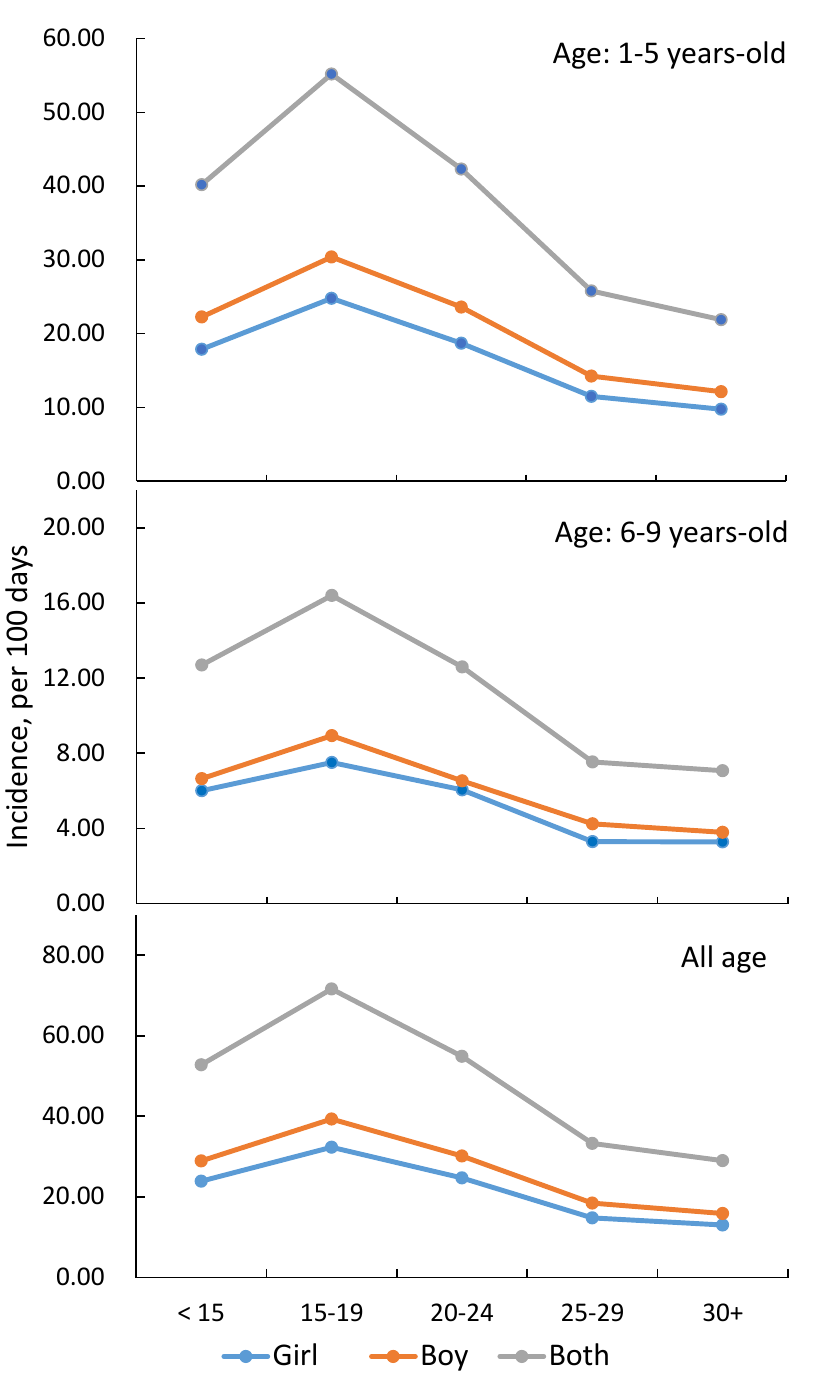
Figure 2. Childhood rotavirus infection cases per 100 days by age and average temperature (°C) for boys and girls in 2006 – 2012 in Taiwan.